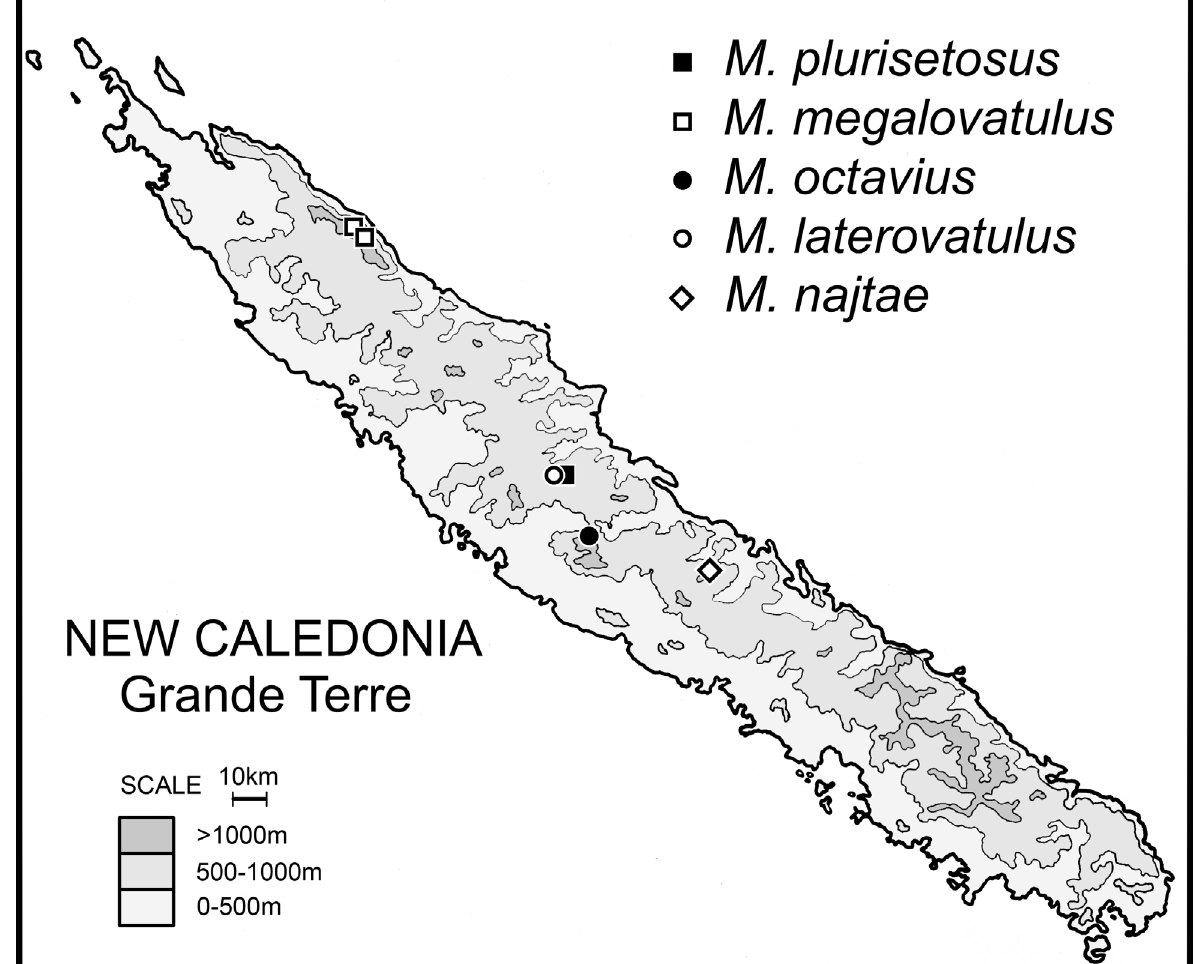
Figure 19. Geographical distributions of Mecyclothorax ( Phacothorax ) spp.